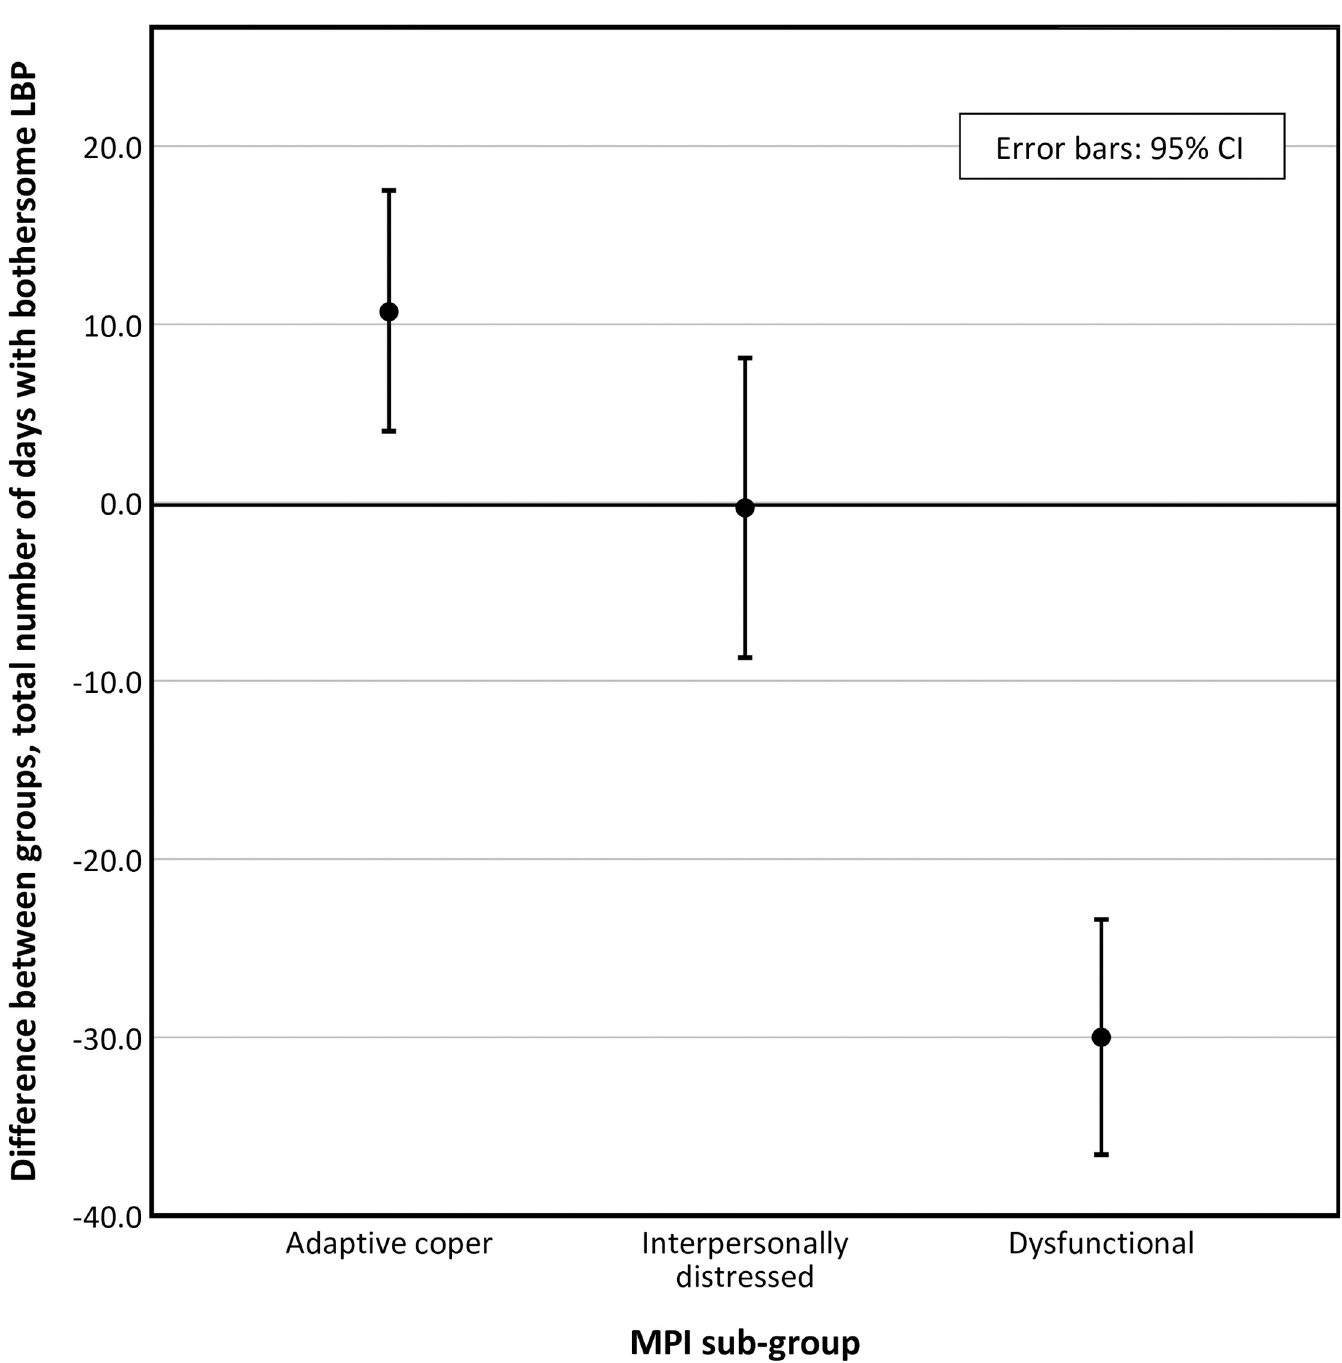
Fig 2. Total number of days with bothersome low back pain, differences between groups (MC-Control). MC ; maintenance care; CI , confidence interval; LBP , low back pain; MPI , West Haven-Yale multidimensional pain